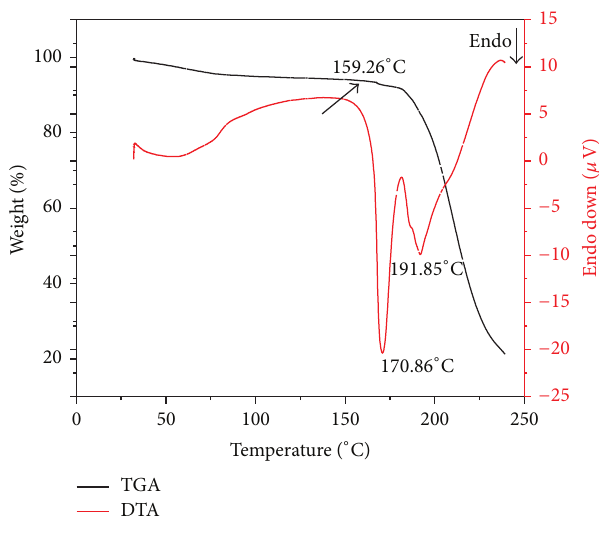
Figure 5: TG/DTA curve of MHT.